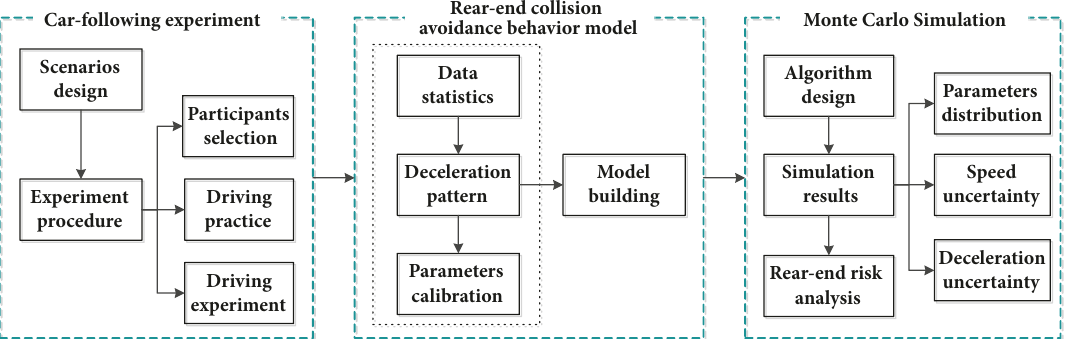
Figure 1: Research framework of this paper.